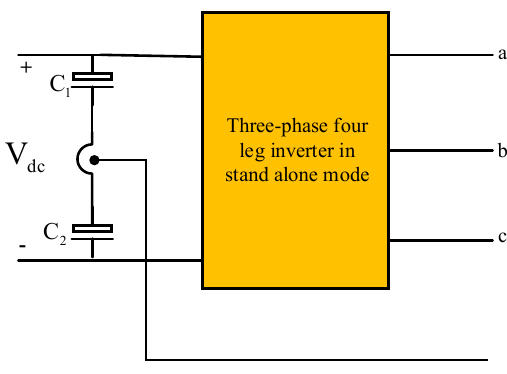
Figure 8. Three-phase four-leg inverter with an output LC filter.